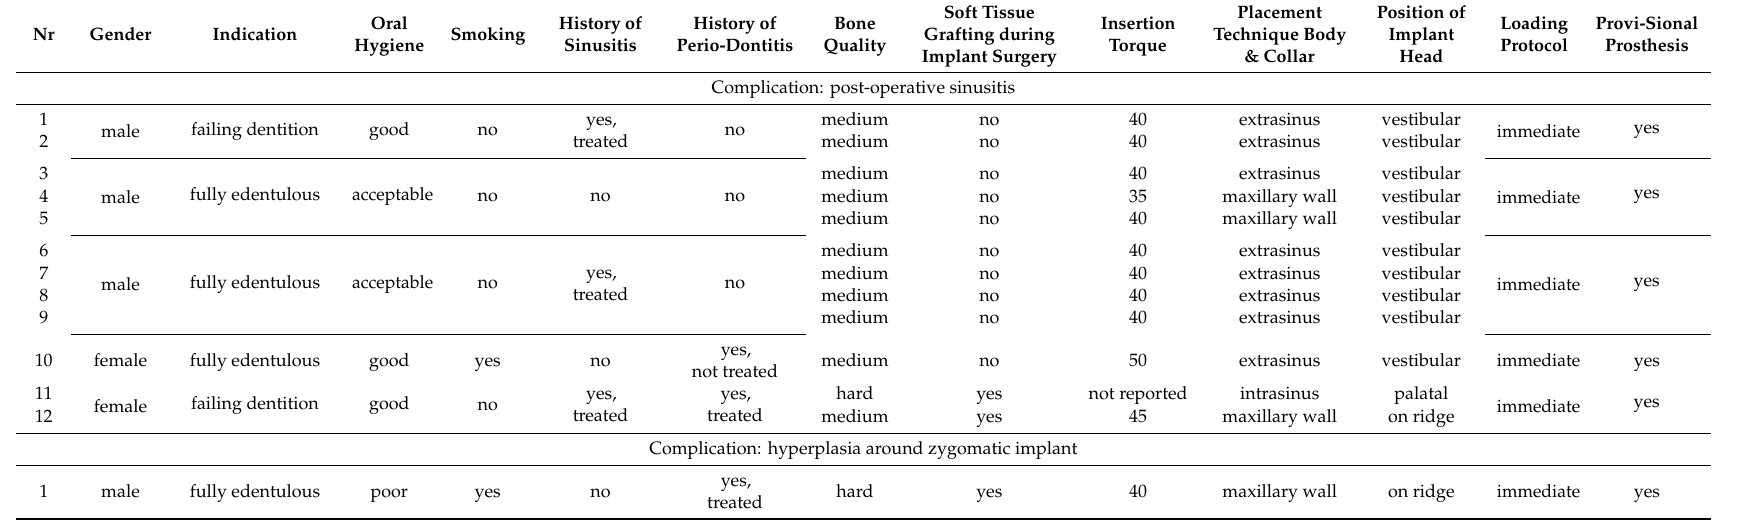
Table 2. Characteristics of implant sites with post-surgical